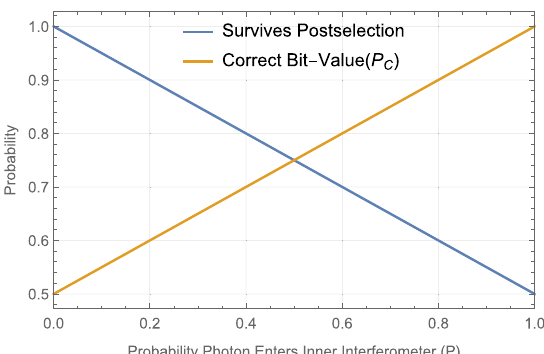
Fig. 4 Postselection success and accuracy probabilities. The total postselection survival probability (blue), and probability of post- selected correct outcome, P C (orange), for a given bit sent from Bob to Alice in the in fi nite inner-cycles case of the protocol, plotted against P , the probability of the photon entering the inner interferometer